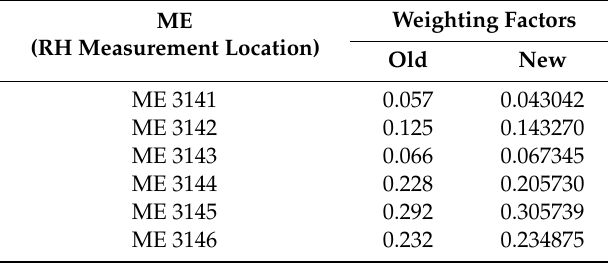
Table 2. Volume weighting factors for RH measurements.